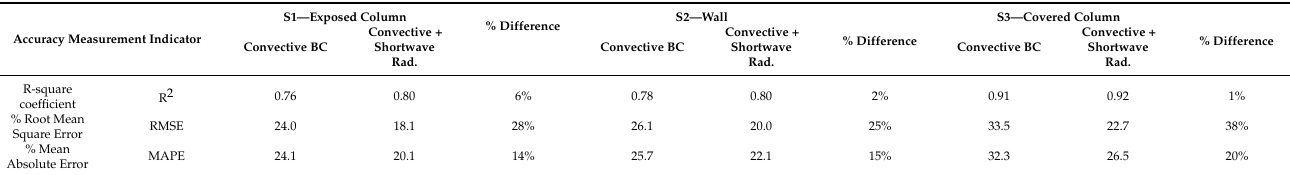
Table 5. Validation results comparison between models with convective boundary conditions and after adding shortwave radiation with a percentage difference.